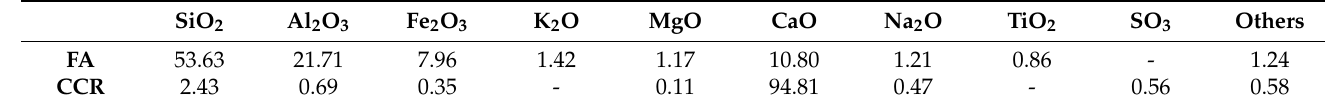
Table 1. The chemical composition of CCR and FA. Values are relative proportions